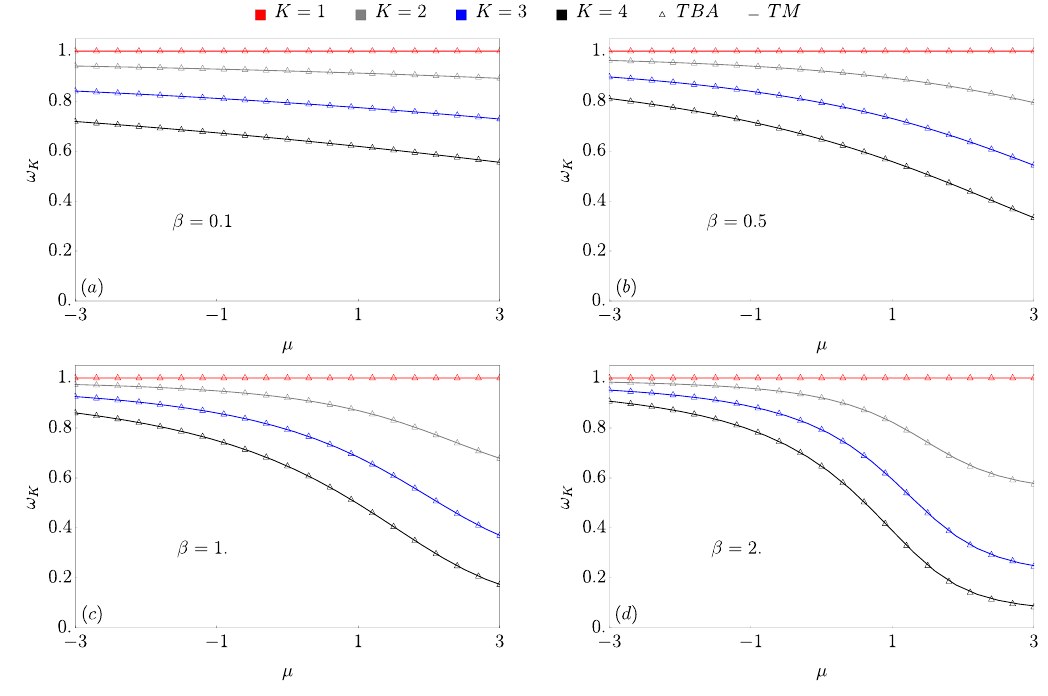
= 〈| φ | 2 K 〉 / [( 〈| φ | 2 〉 ) K K ! ] K = 1, hence any departure from K significantly departs from K